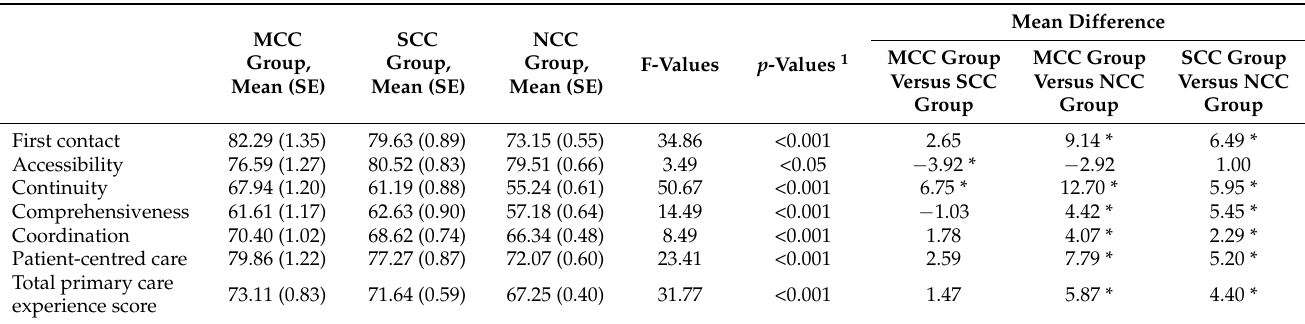
Table 2. Individual and total primary care attribute scores reported by respondents by the number of chronic